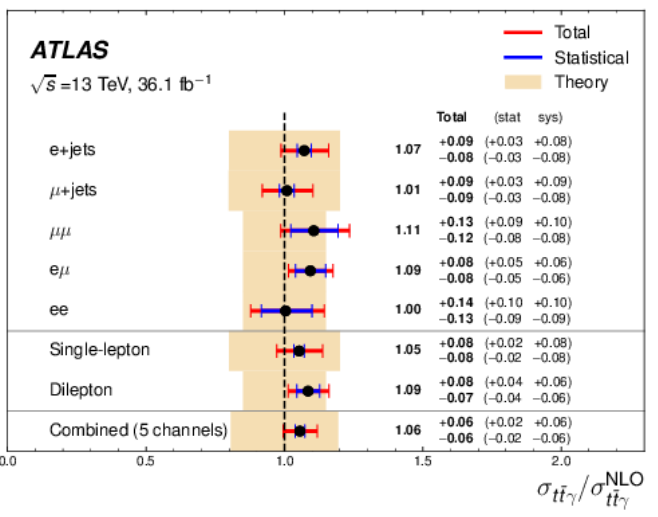
Figure 17. Inclusive t¯t γ production cross-section measurements by ATLAS in leptonic channels [46]. The NLO prediction from theory is shown in the dashed vertical line, with the uncertainty shown in the beige band. The measured values in data are represented by the black points, where the associated total and statistical uncertainties are shown in the red and blue lines, respectively. Results in each of the different lepton flavour channels are also